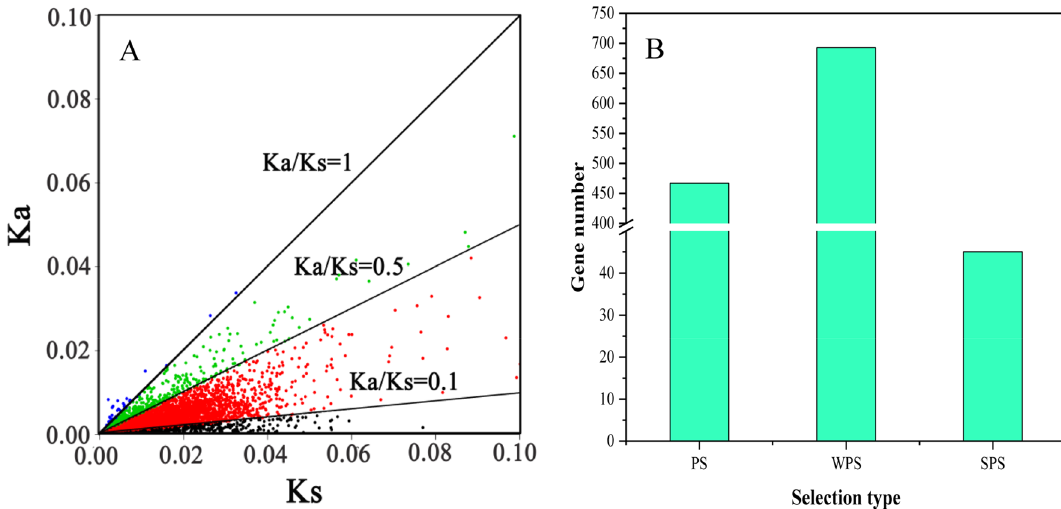
Figure 6. Selection pressure analyses for single-copy genes in common genes of 10 germplasms of Chaenomeles and D. delavayi . In graph A, each coloured dot represents one single-copy gene family. The top diagonal line represents Ka/Ks = 1; the first dotted line represents Ka/Ks = 0.5; and the second dotted line represents Ka/ Ks = 0.1. In graph B, PS is short for purification selection; WPS is short for weak positive selection; and SPS is short for strong positive selection.Scatter diagram was visualized by R 3.6.1. Histogram was visulized by Origin pro